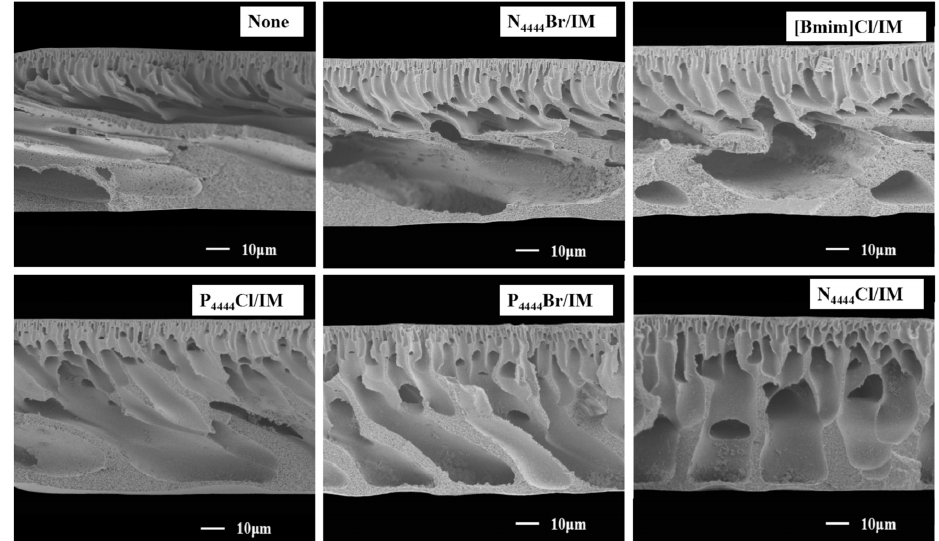
Figure 14. Cross-sectional SEM images of PES membranes with different IM-based DESs as addi- tives [75].